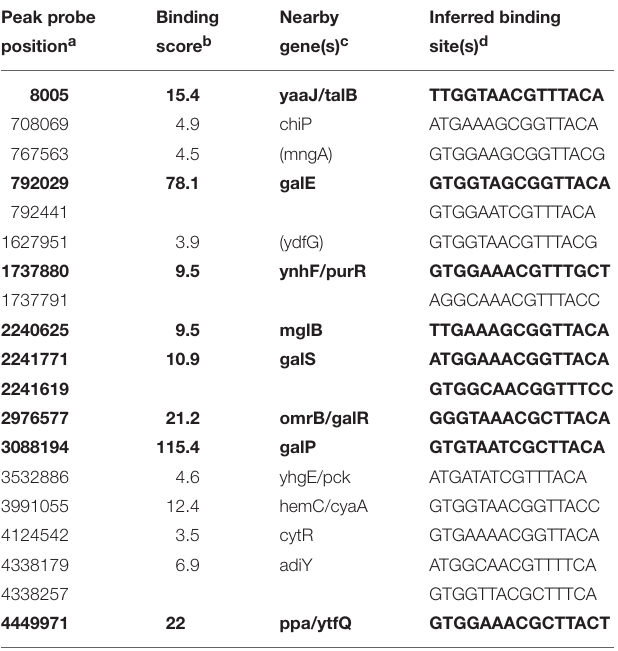
TABLE 3 | GalR-bound regions identified by ChIP-chip assays. Peak probe